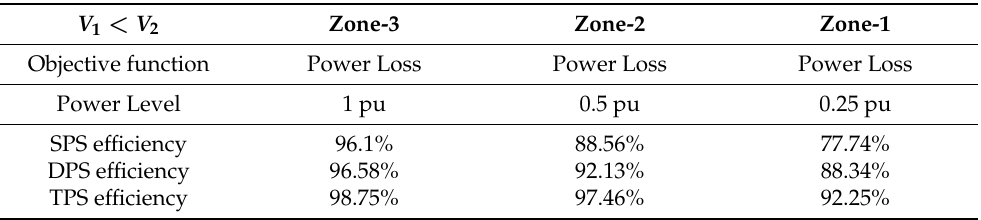
Table 3. Performance comparison of the PLM method for rated 1 pu, medium 0.5 pu, and low 0.25 pu power for